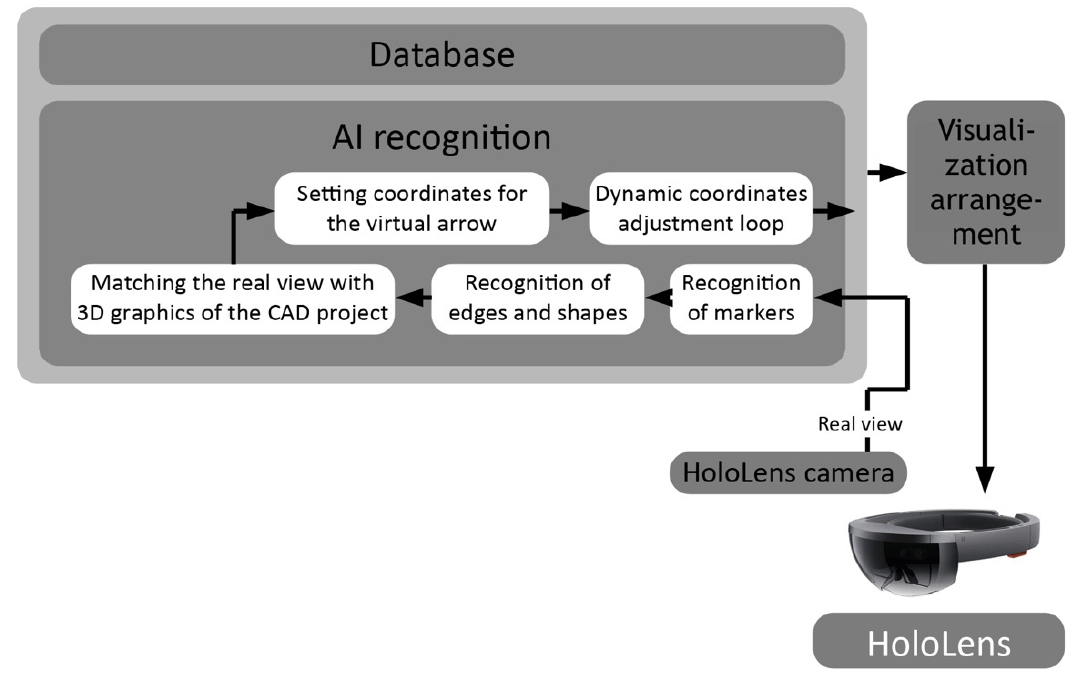
Figure 7. Details of the main DTPoland AR Smart Wiring 4.0 diagram: main functions of the AI recognition subsystem.